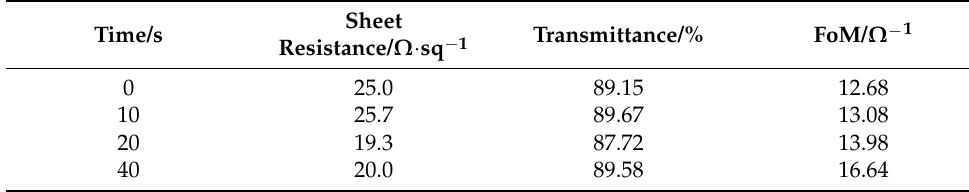
Table 1. Optical and electrical properties at different deposition